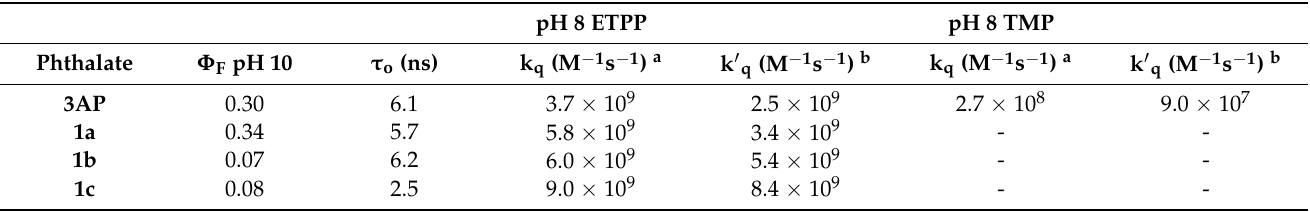
Table 1. Quenching rate constants obtained by: a steady state fluorescence (k q ), b time resolved fluorescence (k (cid:48) q